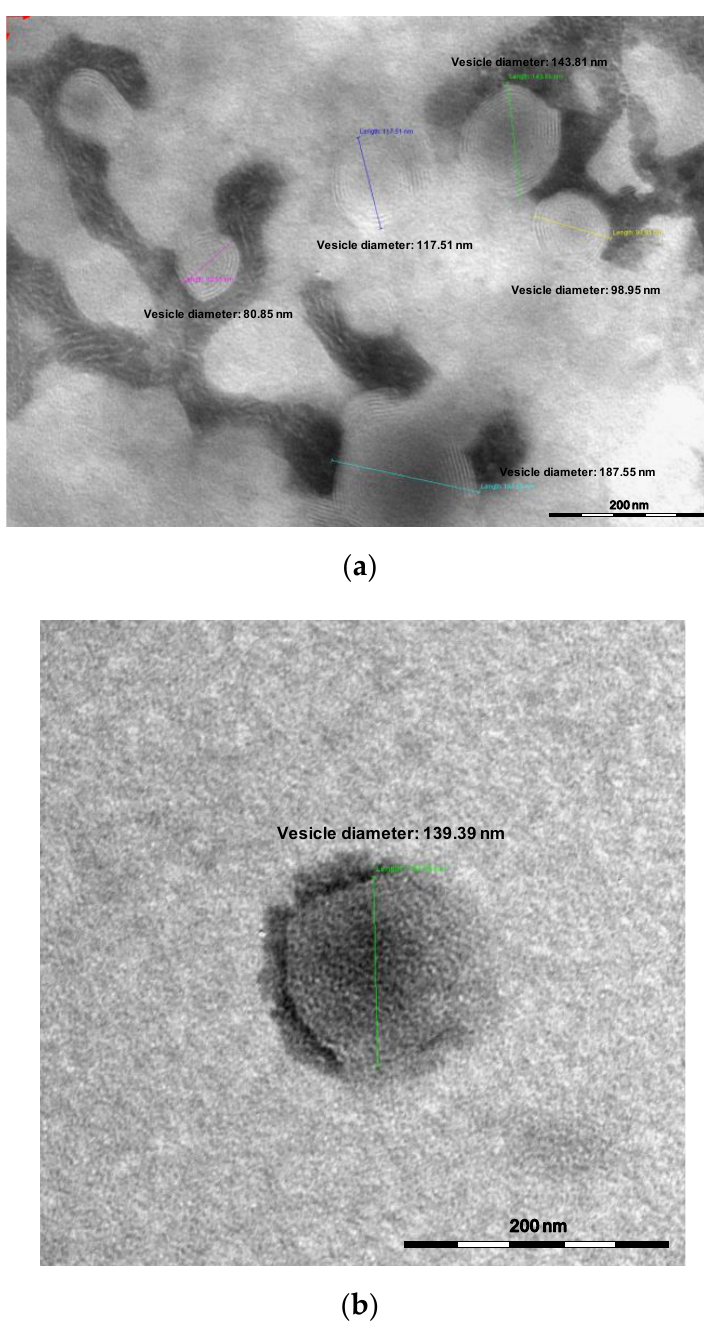
Figure 1. Pictures of ( a ) glycerosomes loaded with O. onites plus S. thymbra essential oils (OOST-GS) and ( b ) propylene glycol-nanovesicles loaded with O. onites plus S. thymbra essential oils (OOST-PGV), obtained by transmission electron microscope (TEM) analysis.